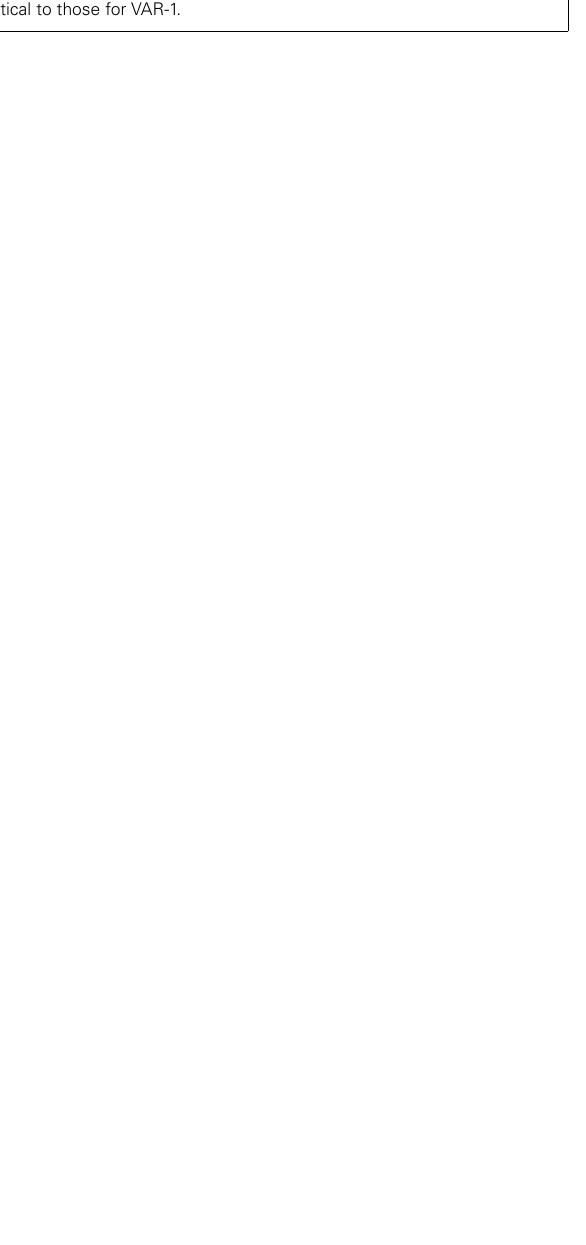
FIGURE A1 | Model robustness. The figure shows the same analysis presented in Figure 1A (2), but for a VAR-3 model. The results are almost identical to those for